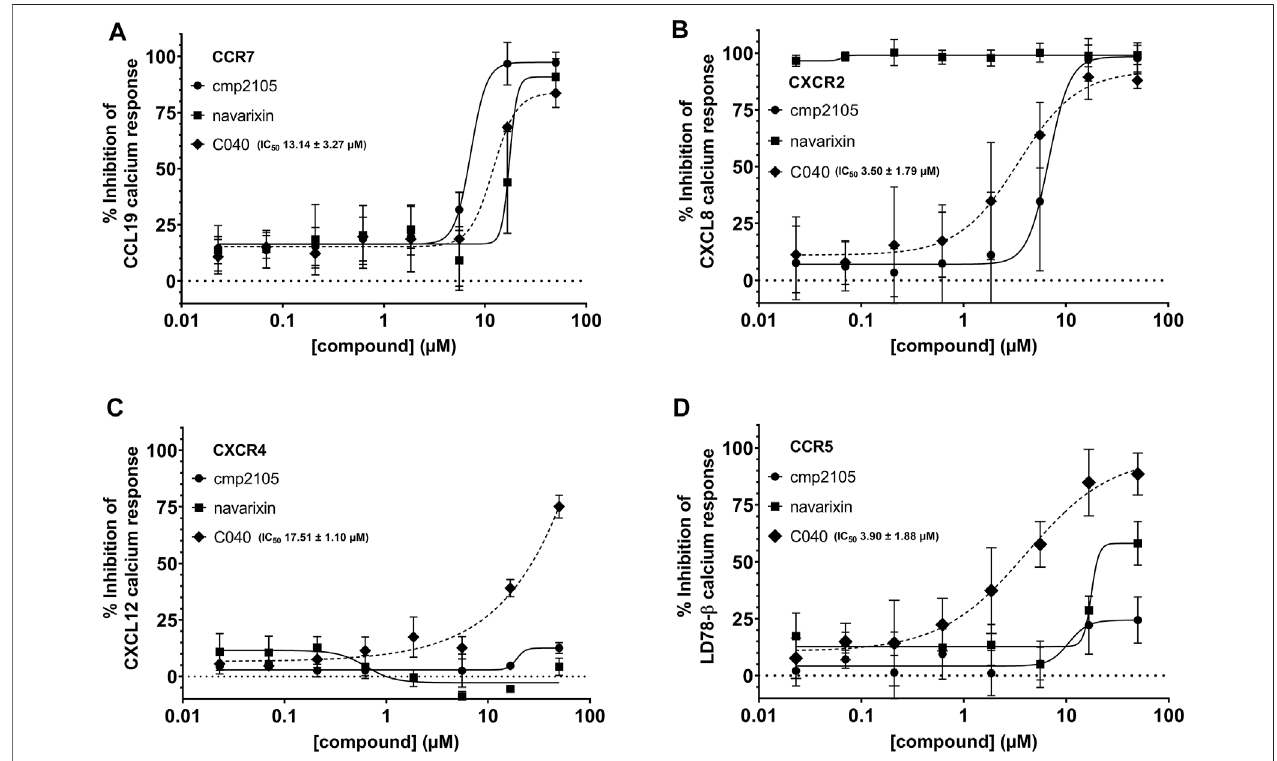
FIGURE 3 | Inhibitionofthe intracellular Ca 2+ release. The ability of cmp2105 , navarixin , and C040 to inhibit the Ca 2+ responseinduced by (A) CCL19-CCR7 (B) CXCL8-CXCR2 (C) CXCL12-CXCR4, and (D) LD78- β -CCR5 was evaluated. Mean ± SD of at least three independent experiments is shown.